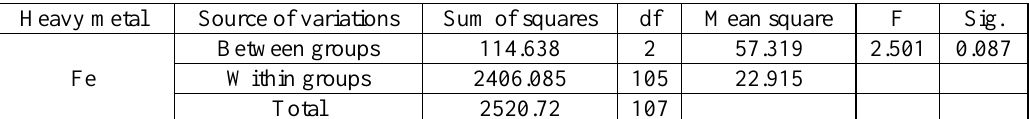
Table 10. One way ANOVA for groundwater iron